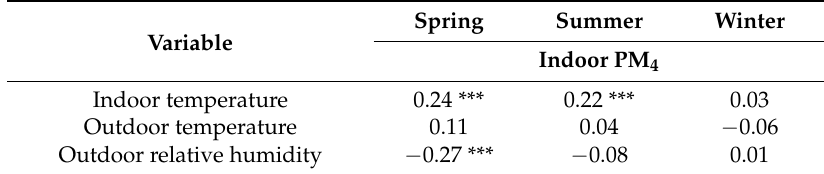
Table 3. Pearson’s correlation coefficients showing the correlation between PM 4 , temperature and relative humidity, stratified by season.